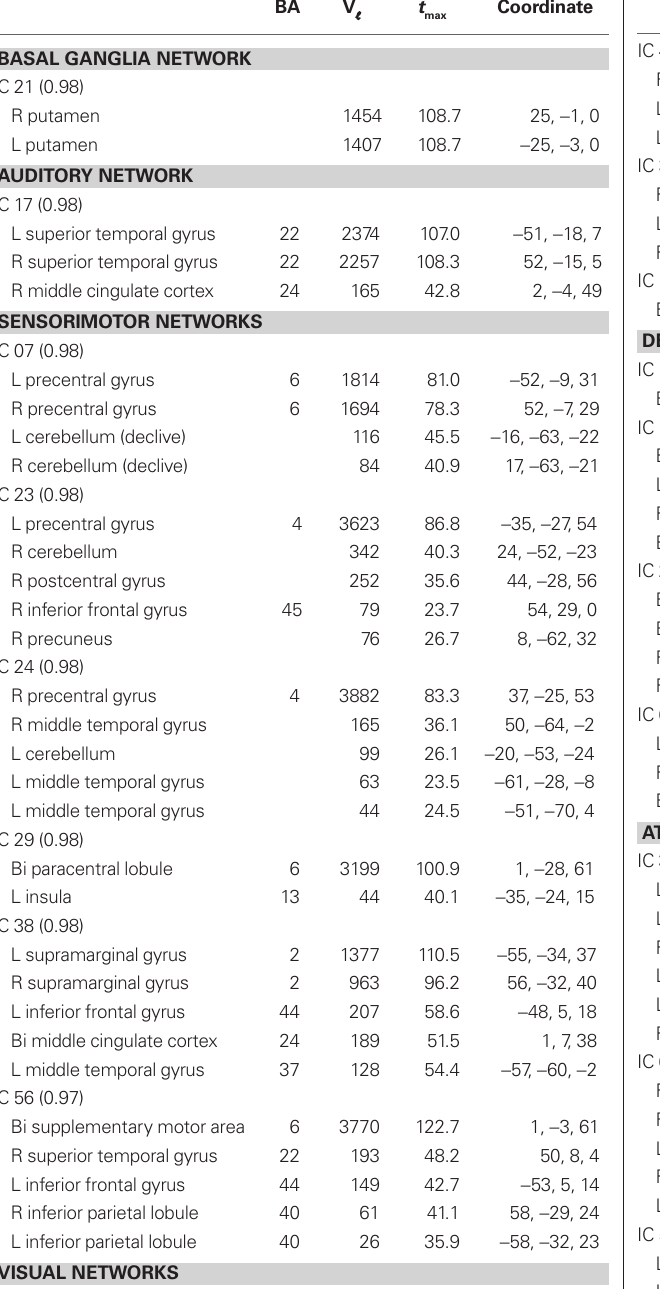
) associated with each RSN is listed in parentheses adjacent to the component number. BA, q , maximum t-statistic in each cluster; Coordinate, coordinate (in mm) of t max